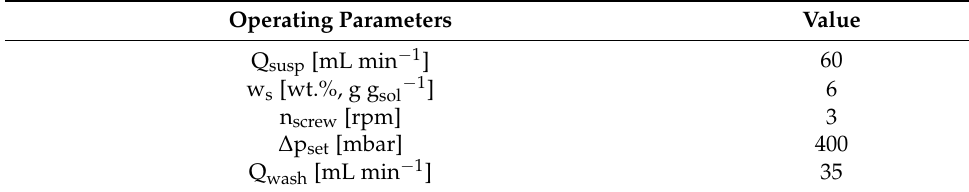
Table 1. Operating parameters for experiments in this study. Q susp : suspension volume flow rate; w s : feed solid mass fraction; n screw : rotational speed of the PTFE screw; ∆ p set : applied vacuum pressure difference; and Q wash : wash liquid flow